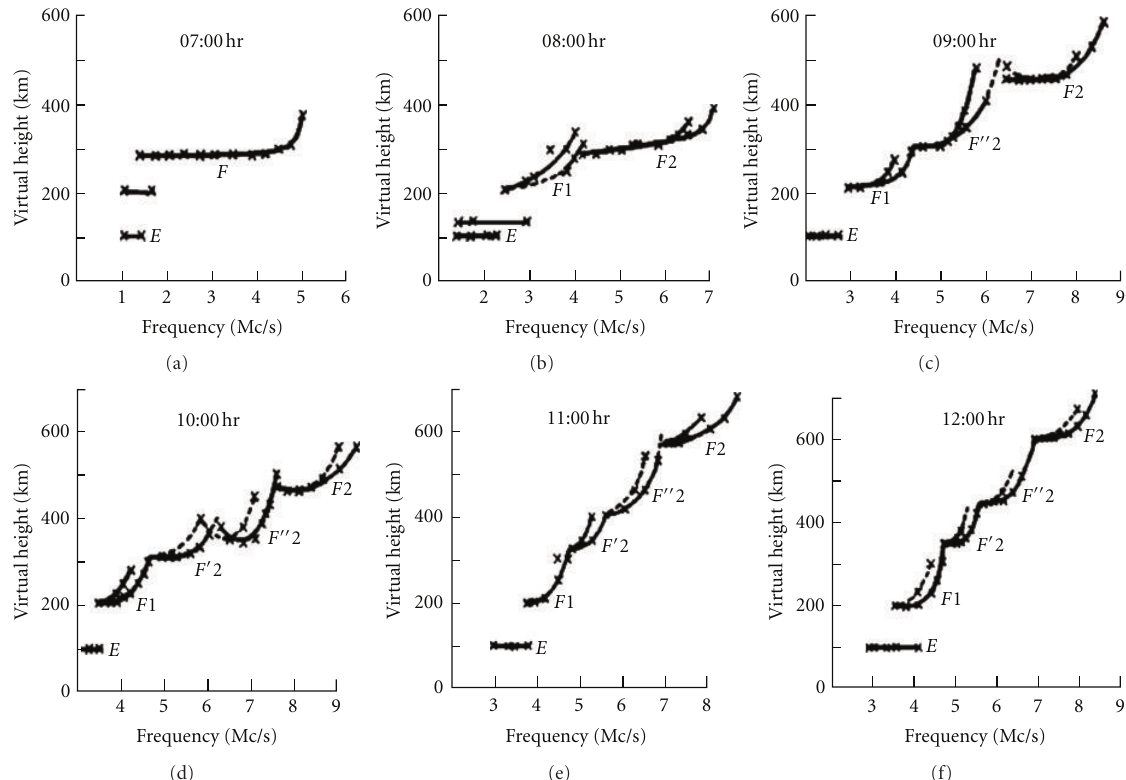
Figure 1: Typical curves of virtual height against frequency, January 8, 1946 (from Sen [2]).